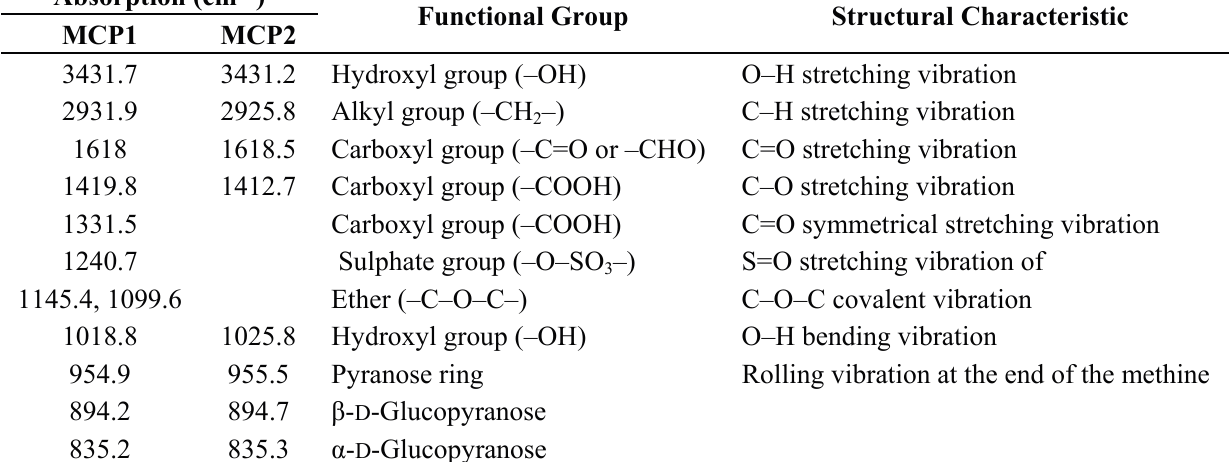
Table 4. FTIR spectrum analysis of the functional groups of MCP1 and MCP2. The FTIR spectra of MCP1 and MCP2 were determined using a FTIR spectrophotometer operating in the frequency range of 4000–400 cm − 1